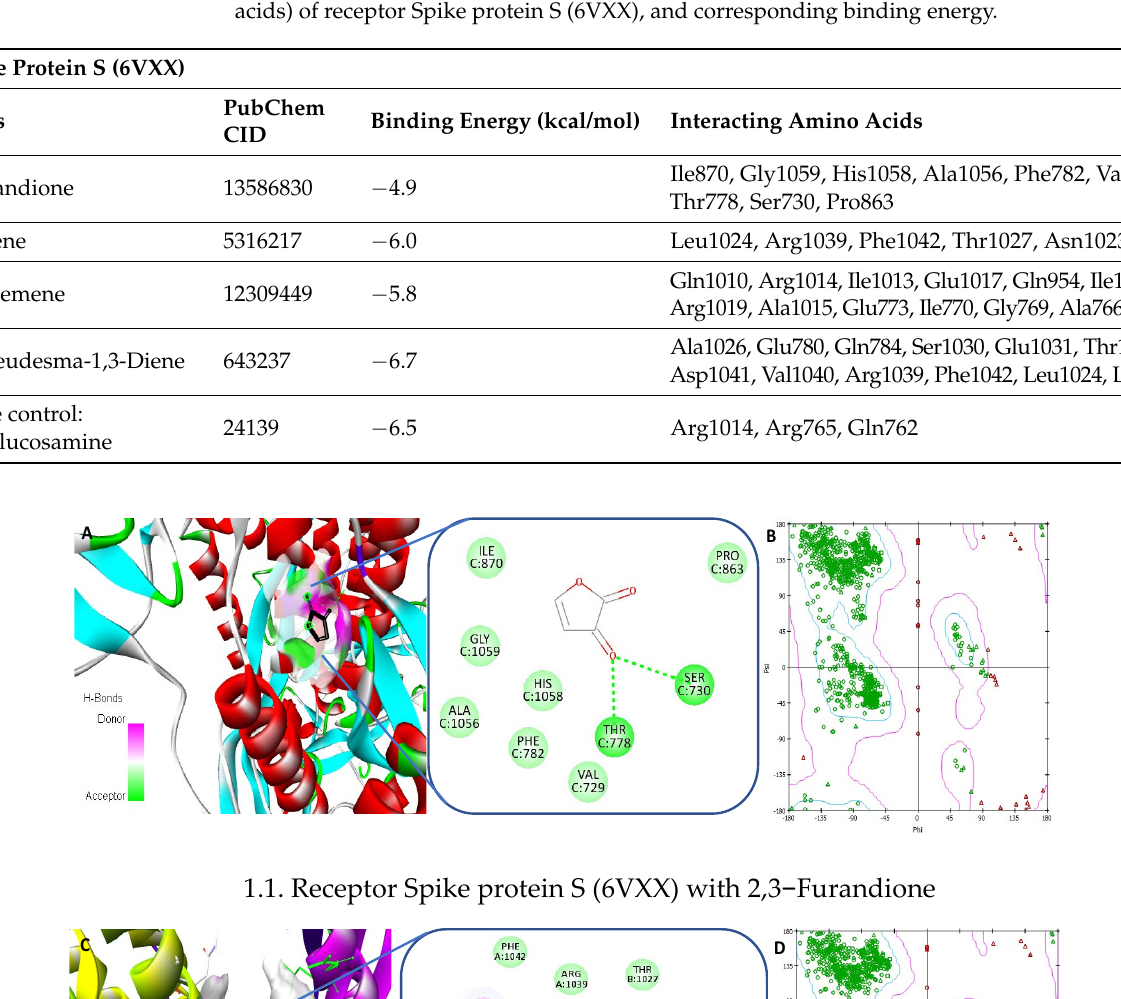
Table 3. Specifications of docking investigations; the ligands, interacting functional residues (amino acids) of receptor Spike protein S (6VXX), and corresponding binding energy.